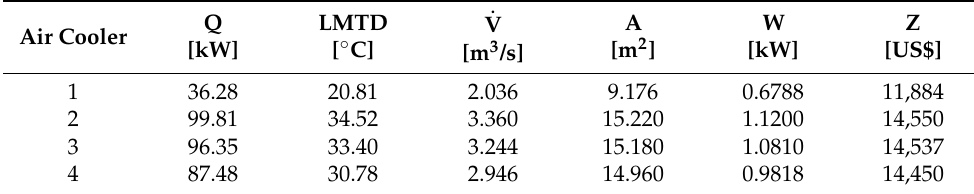
Table 5. Performance data and cost of air